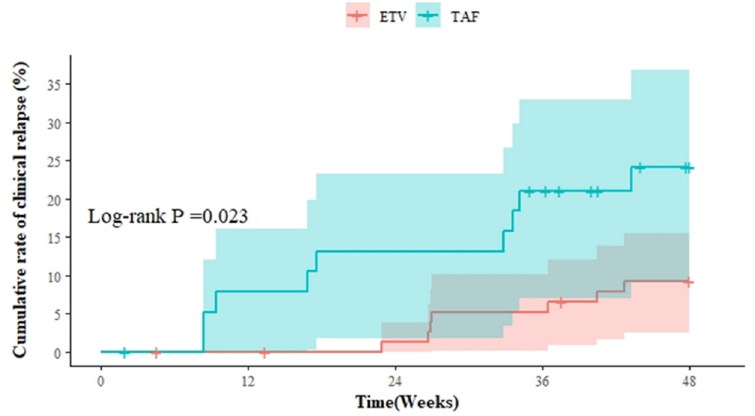
Figure 2. Comparison of HBV clinical relapse after cessation of either entecavir or TAF. The Kaplan– Meier method with a log-rank test was used to analyze the cumulative rate of clinical relapse. R software and the “survival” (https://cran.r-project.org/web/packages/survival/index.html, accessed on 21 January 2023) and “survminer” (https://cran.r-project.org/web/packages/survminer/index.html, accessed on 21 January 2023) packages were used to generate cumulative incidence plots. ETV, entecavir; TAF, tenofovir alafenamide. Table 2. Clinical relapse status for patients after cessation of entecavir or TAF treatments. Time after EOT